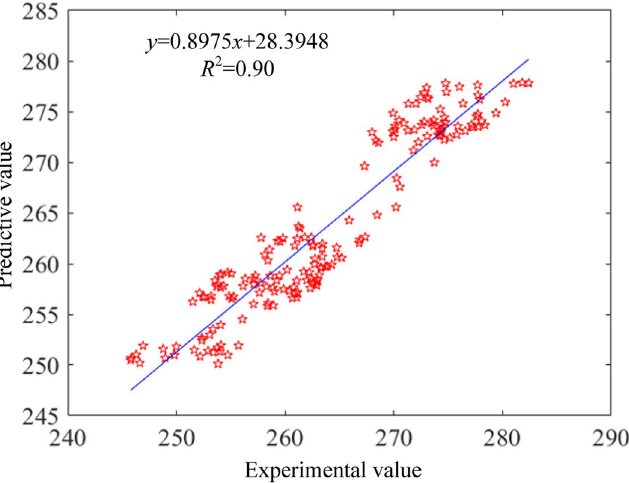
Figure 7. Residual comparison of brake specific fuel consumption between predictive and experimental values.